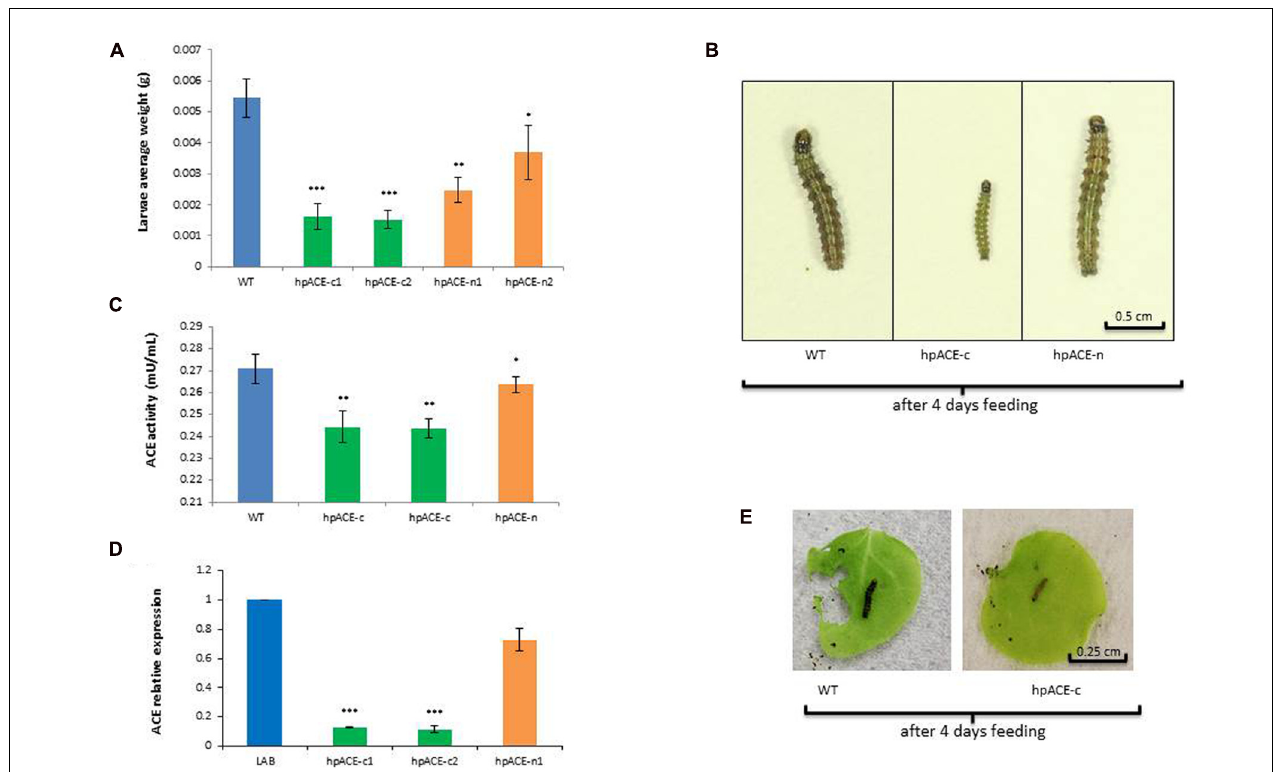
FIGURE 4 | Helicoverpa armigera dsRNA feeding assay. Feeding assays of H. armigera on transplastomic (hpACE-c) and nuclear (hpACE-n) transgenic N. benthamiana . Representation of H. armigera average weight (A) and size (B) , ACE activity (C) and relative expressive (D) after 4 days of feeding on WT, transplastomic hpACE-c and nuclear hpACE-n transformants. All data are means ± SD ( n = 30) after 4 days of caterpillars feeding on 2 week old seedlings. Significant differences to wild type were identified by analysis of variance using ANOVA. ∗ , ∗∗ , and ∗∗∗ indicates a significant difference at P < 0.5, 0.1, and 0.001, respectively. An example of feeding assay with 3 wo detached leaves is represented in (E)